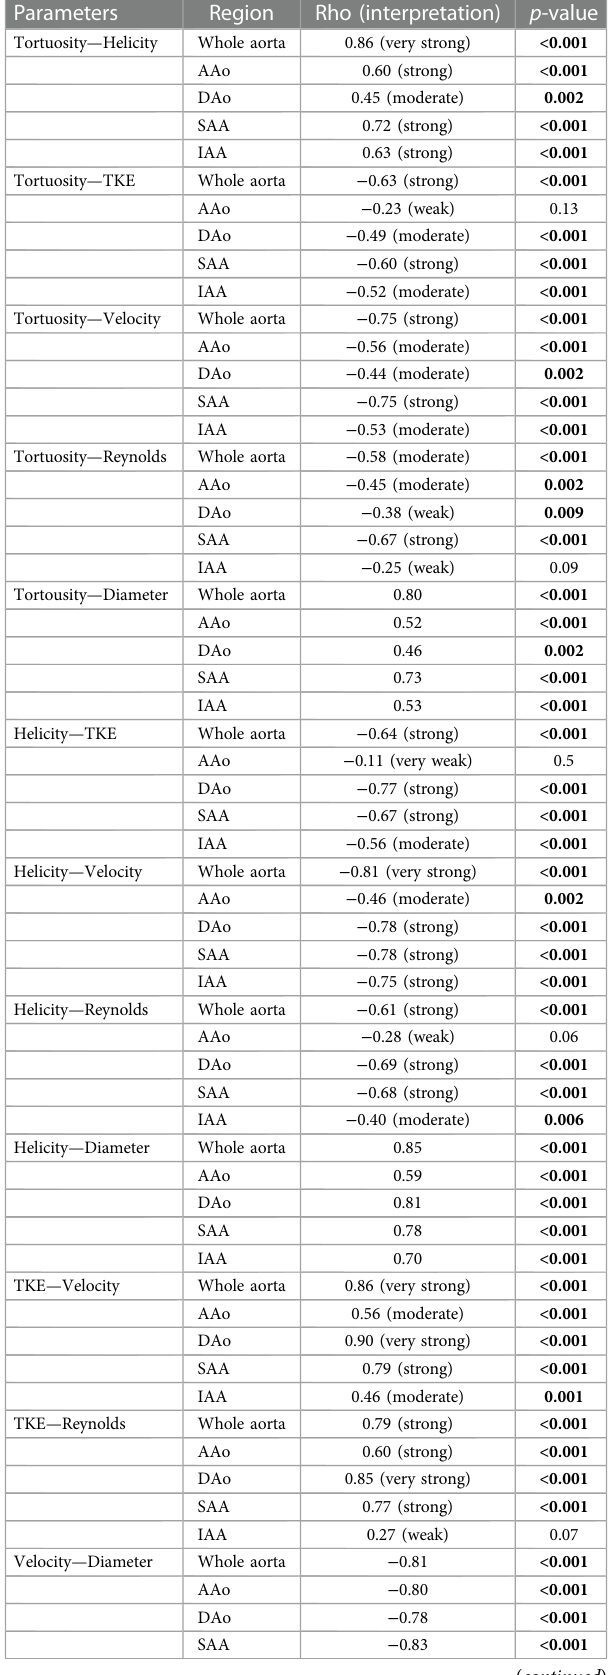
TABLE 2 Cohort-averaged geometric and hemodynamic parameters per aortic region.